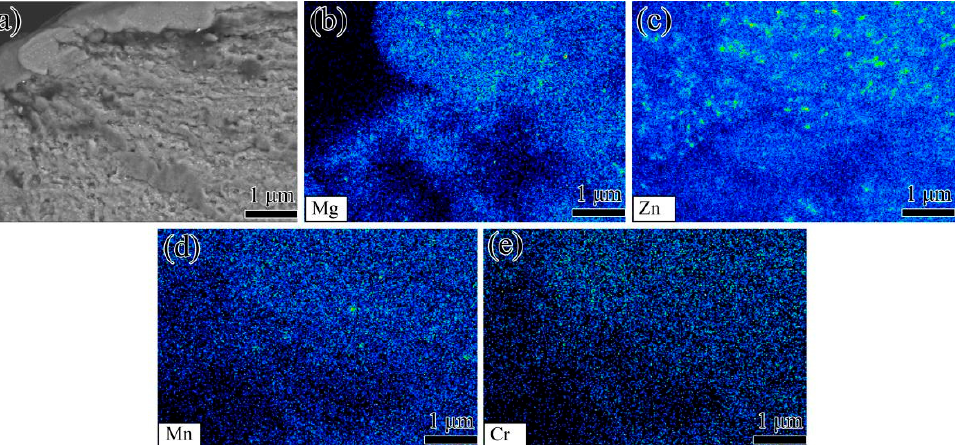
Figure 10. WDS images of fatigue fracture initiation in annealed 7005 aluminum alloy plate sub- jected to 3% pre-tensile deformation: ( a ) fatigue fracture initiation, ( b ) Mg element, ( c ) Zn element, ( d ) Mn element, ( e ) Cr element.